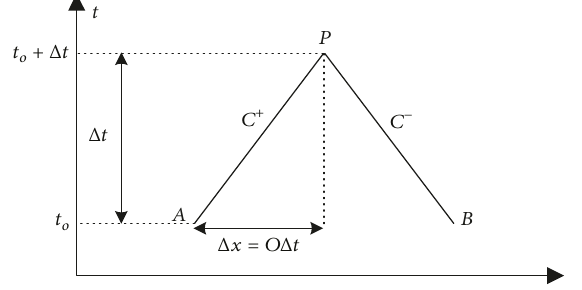
Figure 4: The working mechanism of the characteristic line. A and B representthesectionalareasintheupstreampipeanddownstream pipe, respectively. When the diameter of pipe keeps unchanged, the sectional area A equals B .